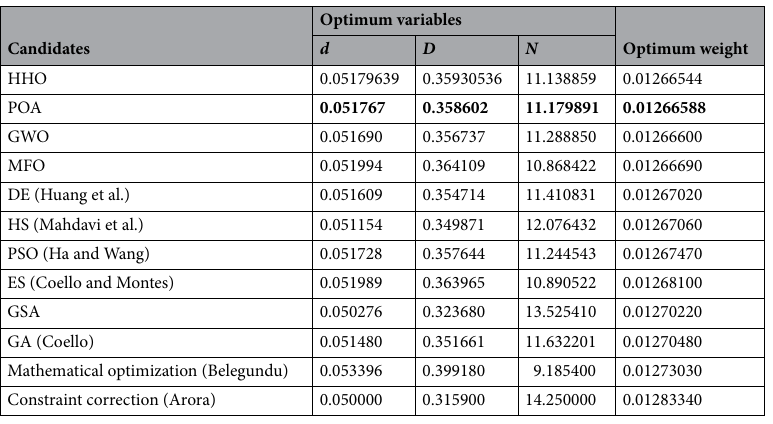
Table 13. Comparison of results for tension/compression spring. Significant values are in bold.